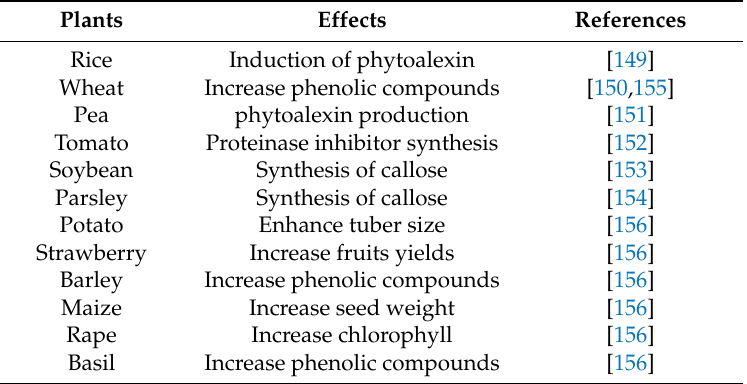
Table 3. Oligochitins/COS as biostimulators and elicitors of plants defenses. Plants